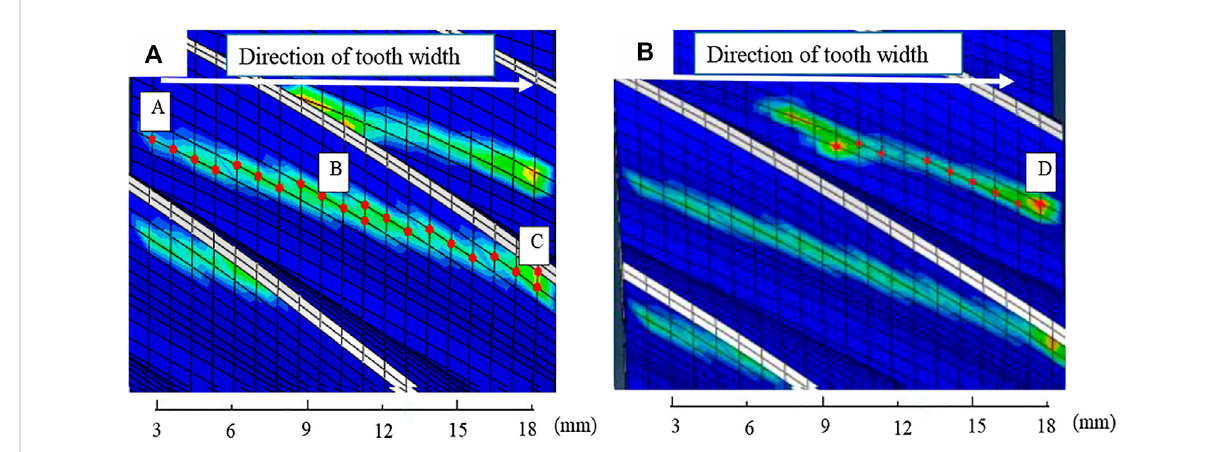
FIGURE 11 Schematic of the local points on the engagement line. (A) Contact stress of tooth 2 and (B) Contact stress of tooth 3.